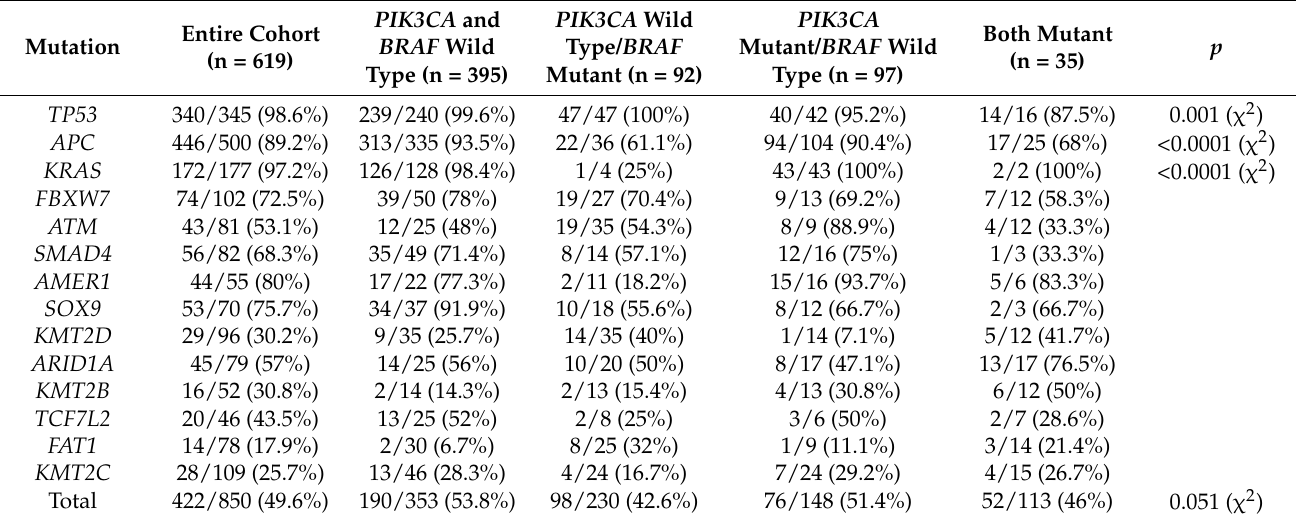
Table 6. Prevalence of functionally annotated mutations as oncogenic/probably oncogenic in DFCI. The nominator in each case represents number of oncogenic or probably oncogenic mutations and the denominator represents the total number of mutations of each gene in each group.